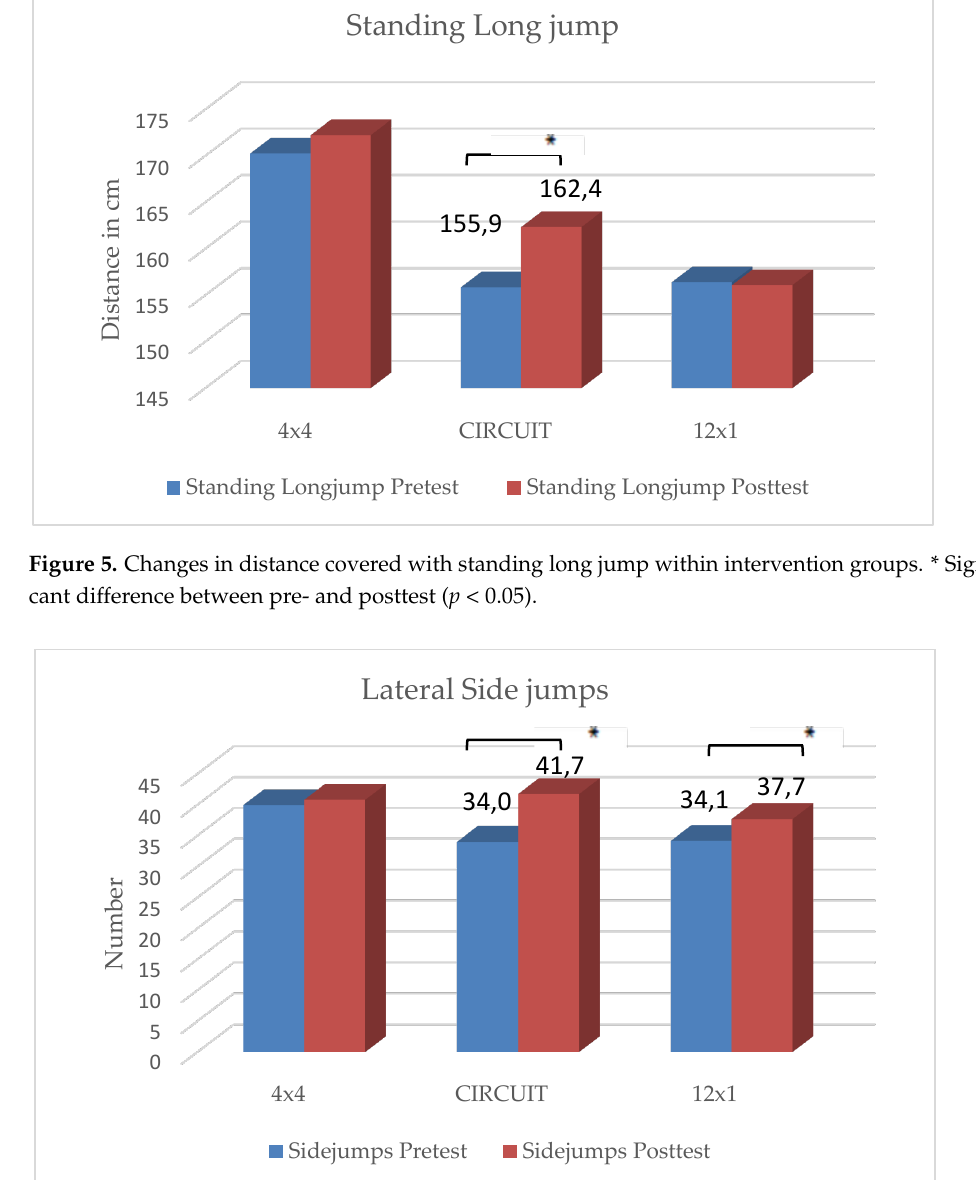
Figure 4. Changes in number of sit-ups within intervention groups. * Significant difference between pre- and posttest ( p < 0.05).